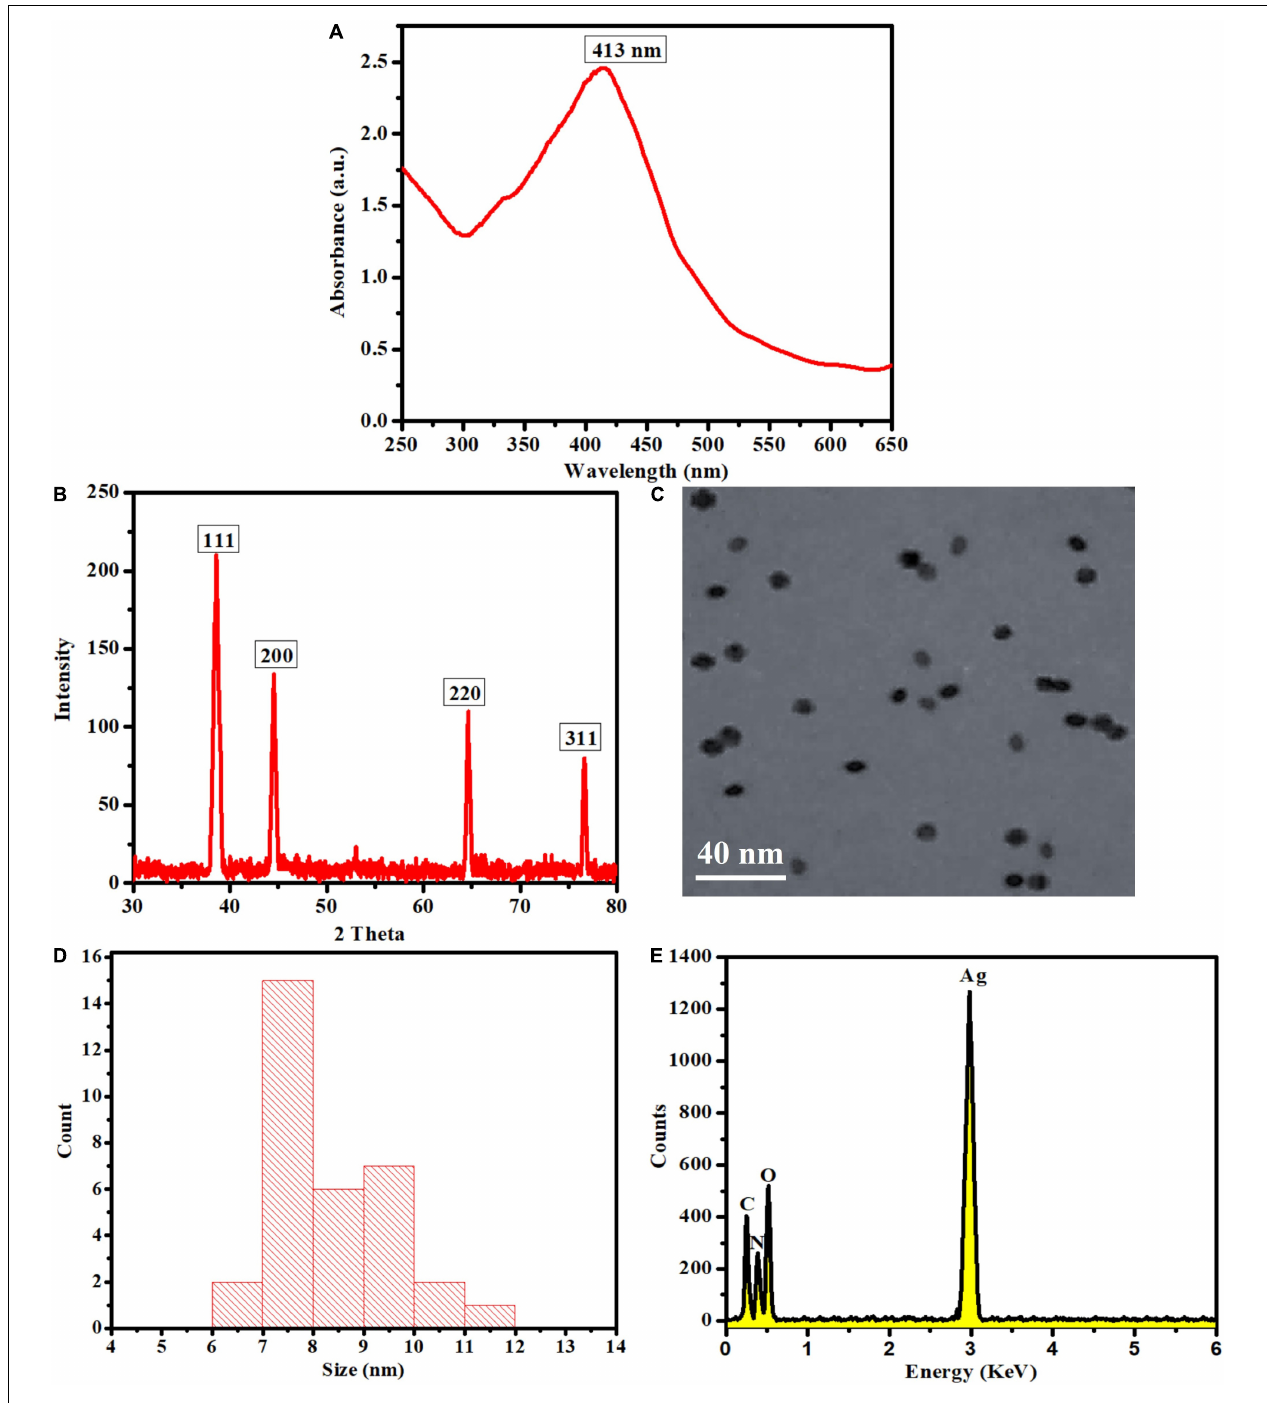
FIGURE 2 | (A) UV-Visible spectra, (B) XRD, (C) TEM, (D) size distribution, and (E) EDX pattern of the biosynthesized LEVB-Ag